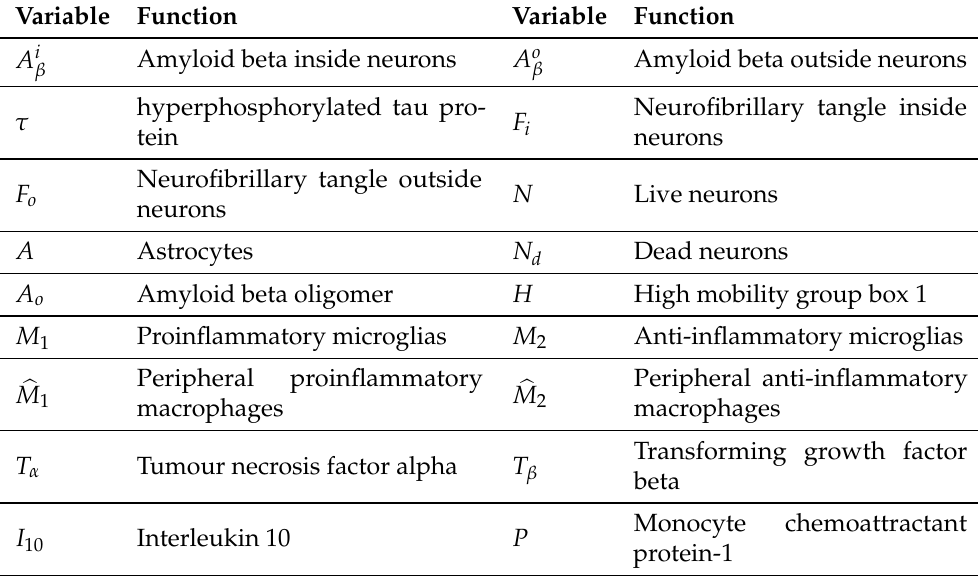
Table 3. The variables of the model and their functions.